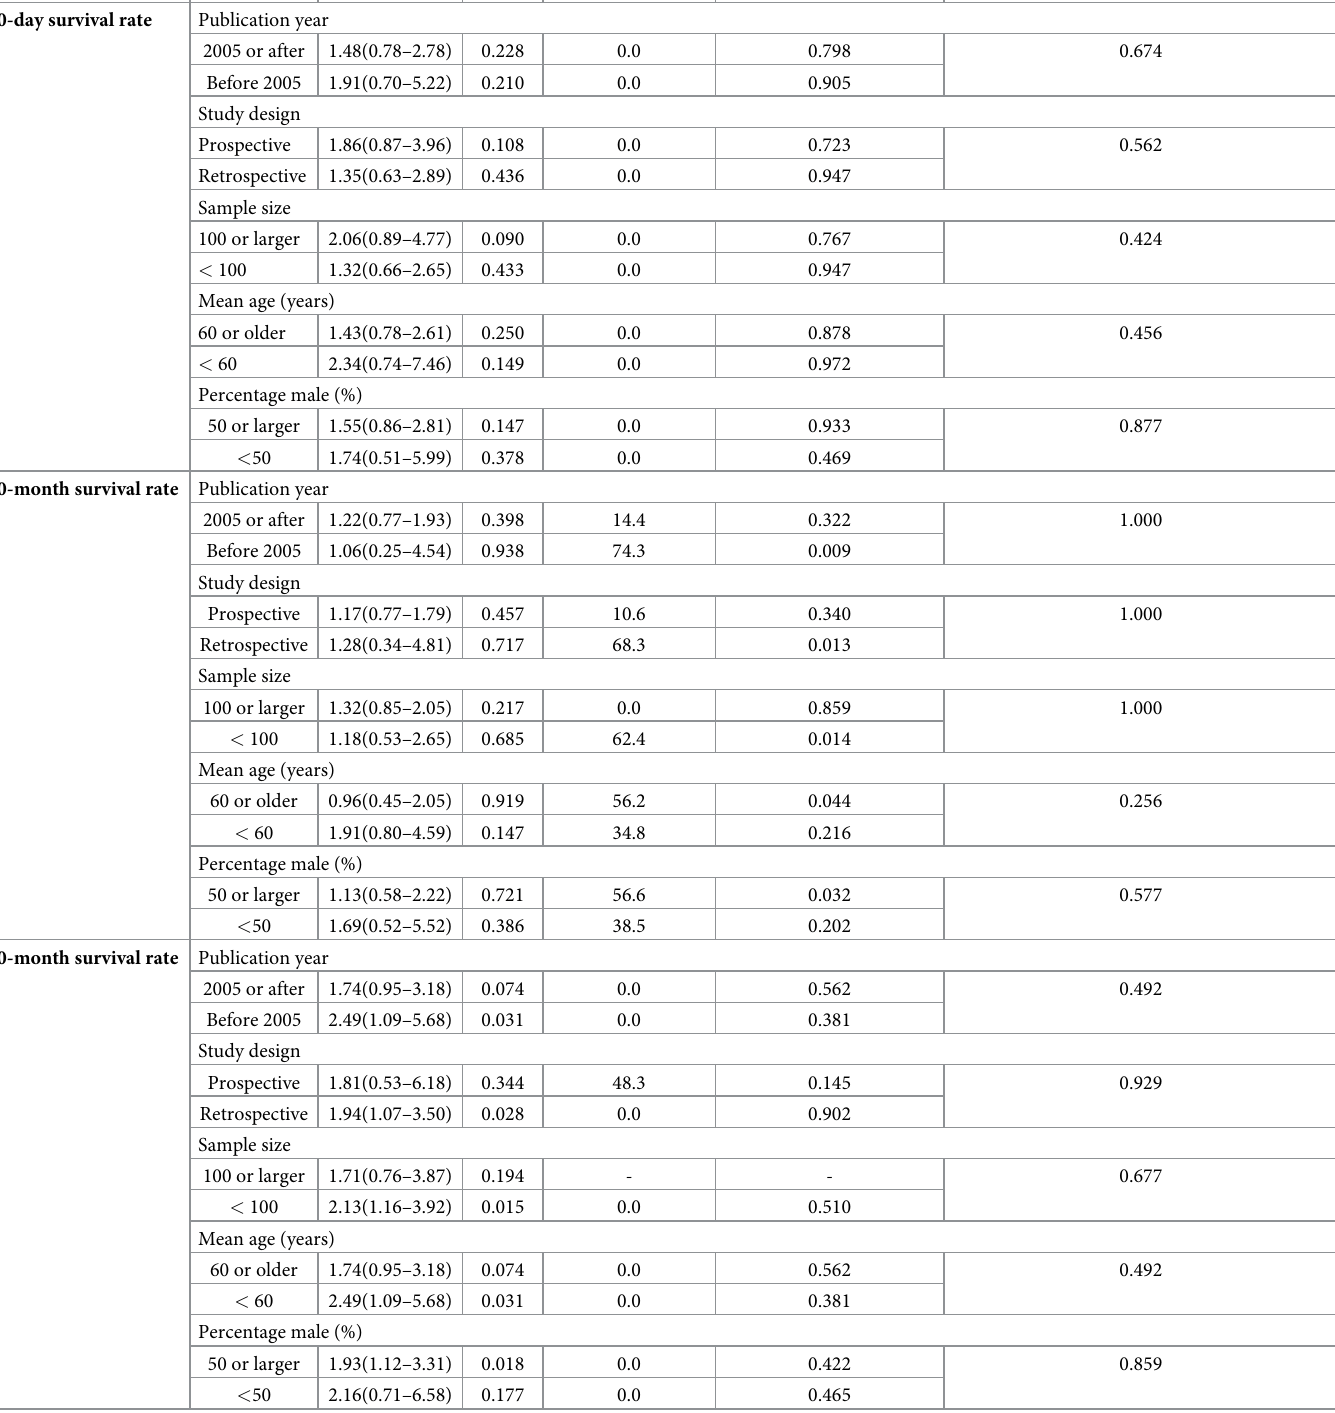
Table 3. Subgroup